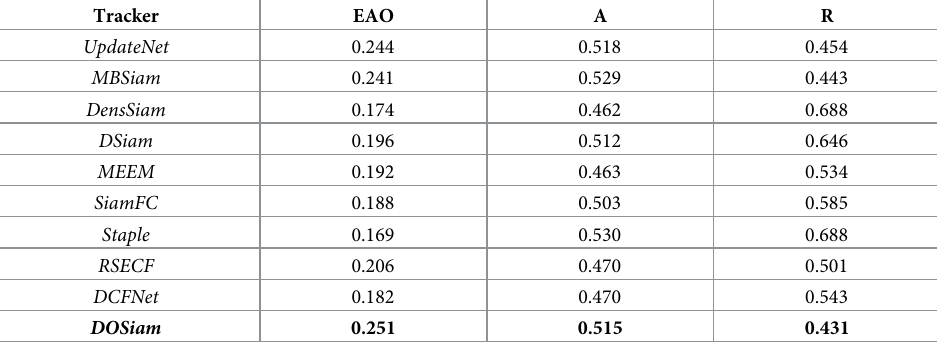
Table 3. Comparison with state-of-the-art trackers on VOT2018 in terms of EAO, A and R. Tracker EAO A R UpdateNet